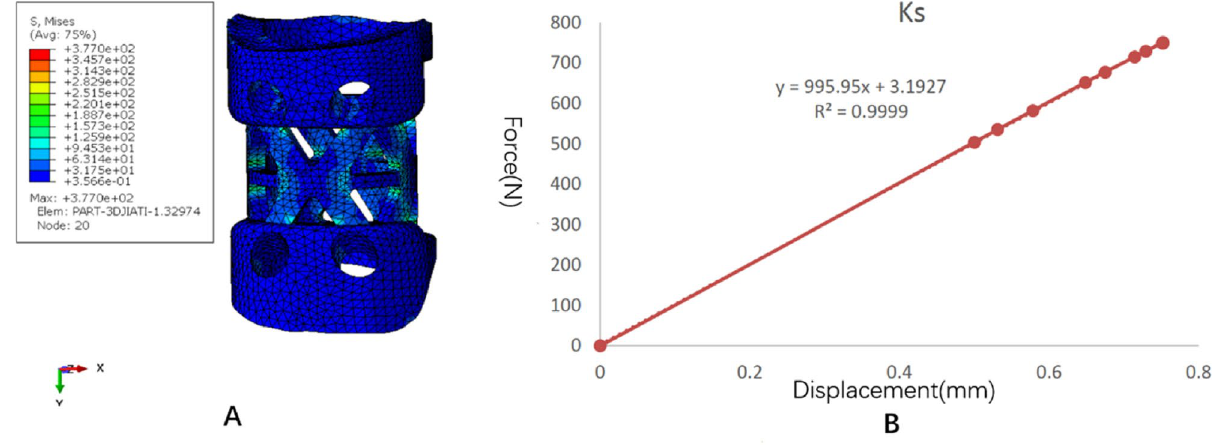
Figure 8. The stress distribution and the force displacement curve of the novel titanium mesh cage (NTMC)’s Ks. ( A ) The stress distribution diagram; ( B ) the force displacement curve (Abaqus 2016, SIMULIA Co, USA).